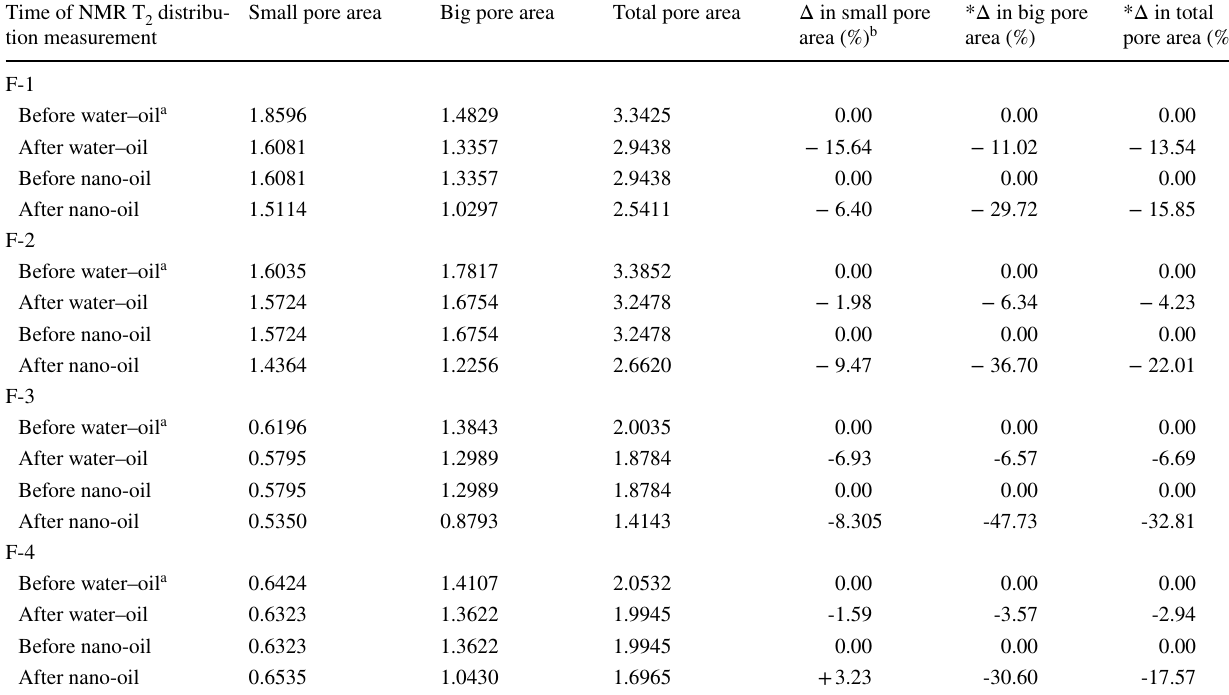
Table 4 Effect of nanoparticles on NMR T